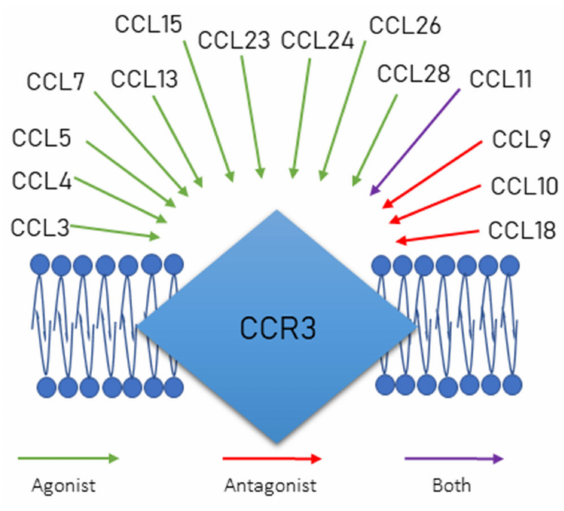
Figure 4. CCR3 and its